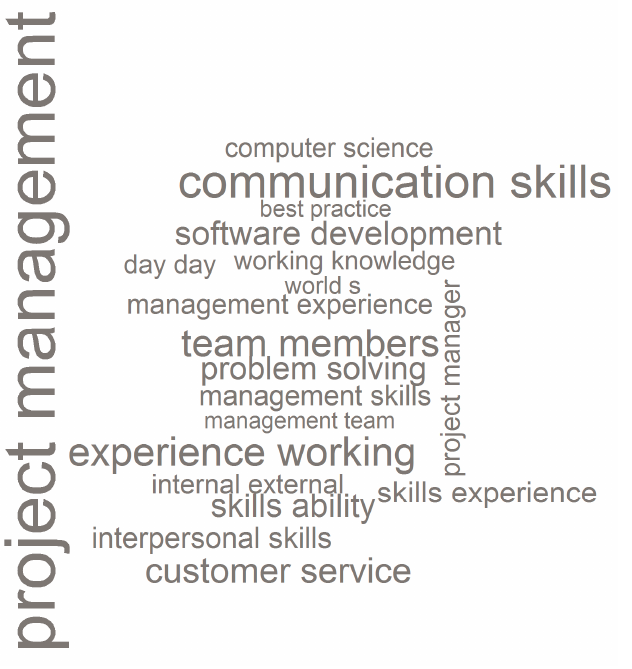
Figure 17. Job Descriptions Visualization—Lead (unseen data).